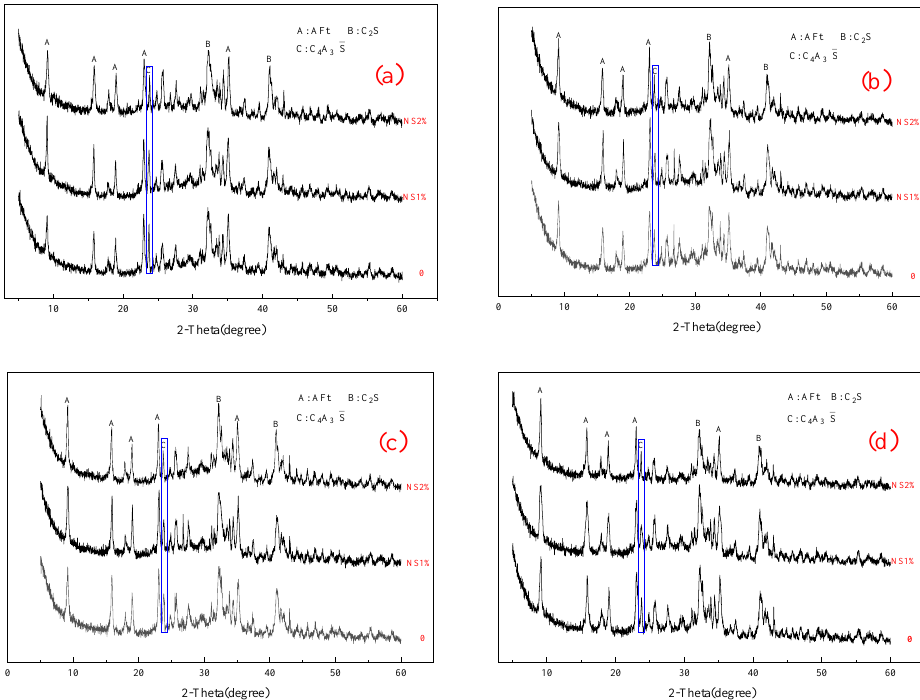
Figure 5. X-ray diffraction (XRD) patterns of the HBSAC cement with different contents of nanosilica sol: ( a ) 3 h; ( b ) 6 h; ( c ) 1 day; ( d ) 28 days.